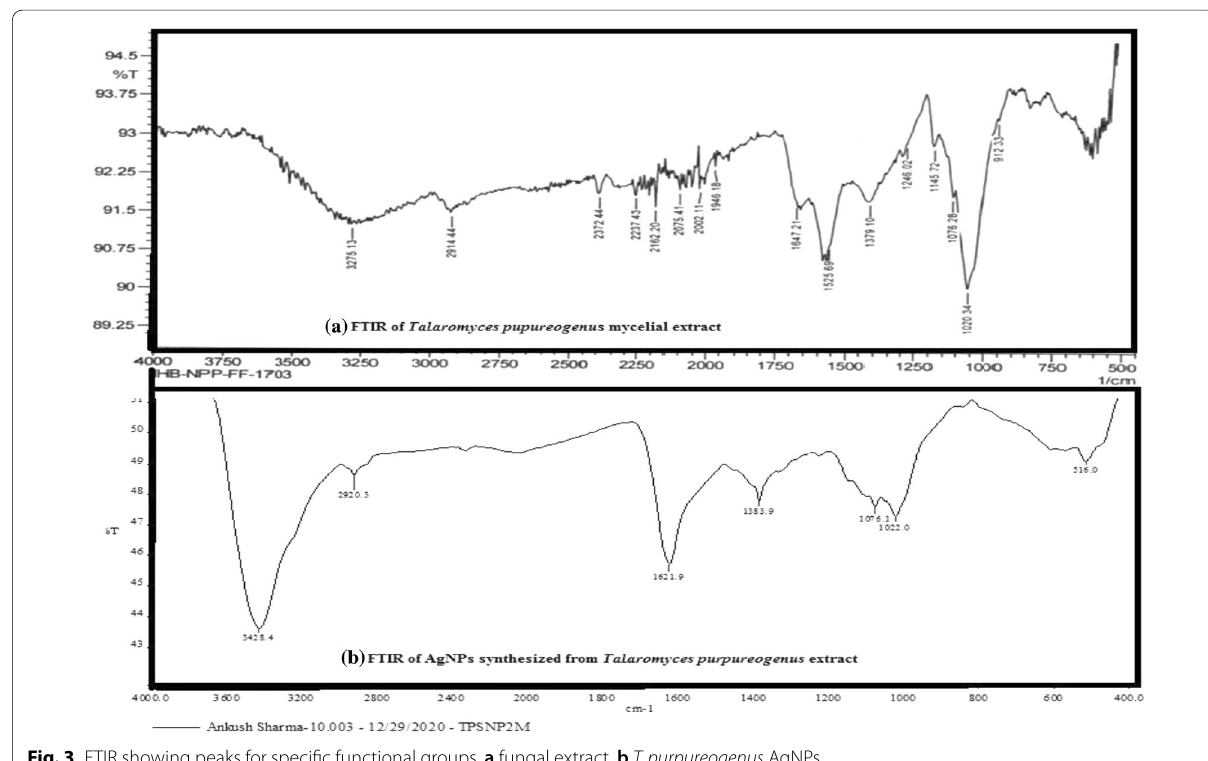
Fig. 3 FTIR showing peaks for specific functional groups, a fungal extract, b T. purpureogenus AgNPs